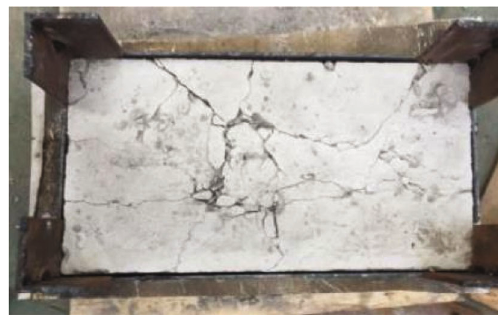
Figure 2: Broken layer